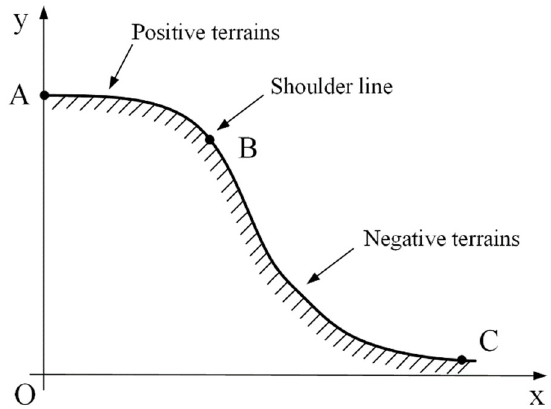
Figure 1. Illustration of a typical terrain profile near the loess shoulder-line [9].